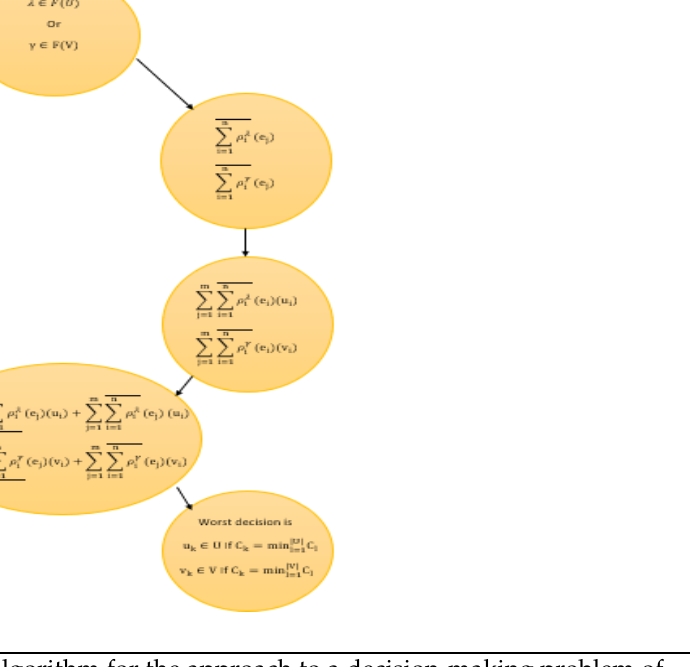
Algorithm 1: An algorithm for the approach to a decision-making problem of thew.r.t aftersets is presented in the